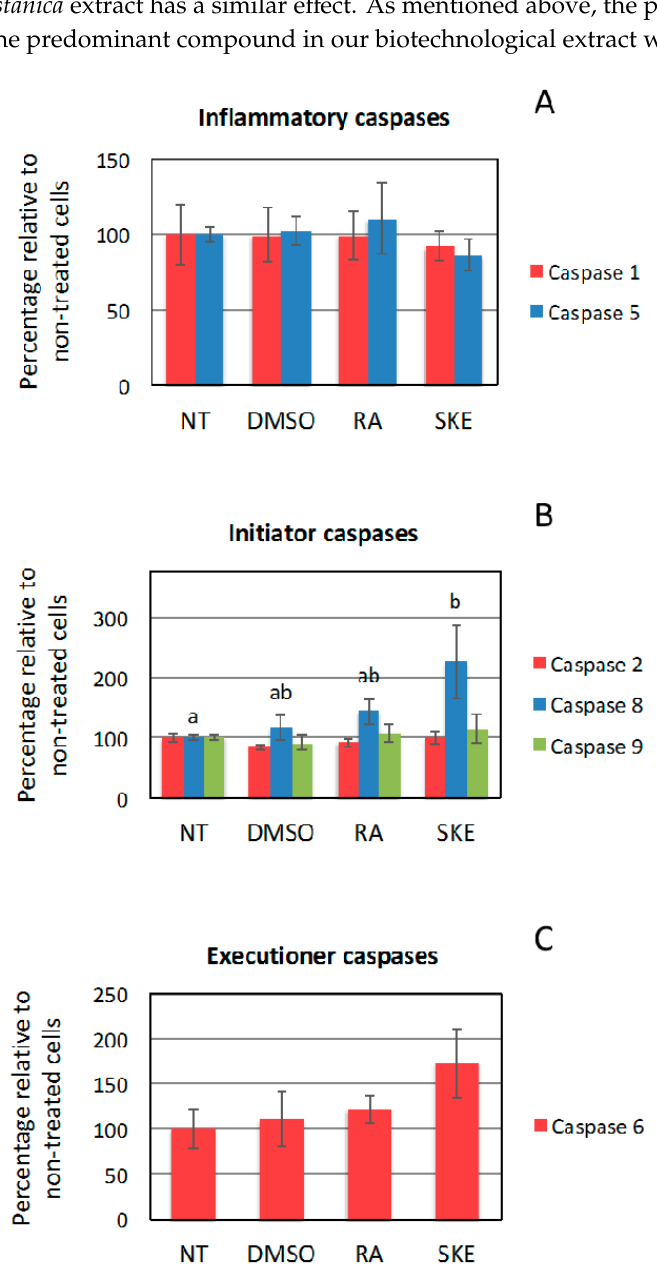
Figure 6. Assay of caspase activity in MCF-7 cells treated with S. khuzistanica extracts. The activity of inflammatory ( A ), initiator ( B ) and executioner ( C ) caspases was assayed in MCF-7 cells treated for 48 h with 0.6 mg·mL − 1 S. khuzistanica extract (SKE), 0.4 mM rosmarinic acid (RA) or 0.4% DMSO (vehicle). Control cells were non-treated (NT). Each bar represents the mean ± SD of three replicates. Different letters indicate significant differences between treatments ( p < 0.05).